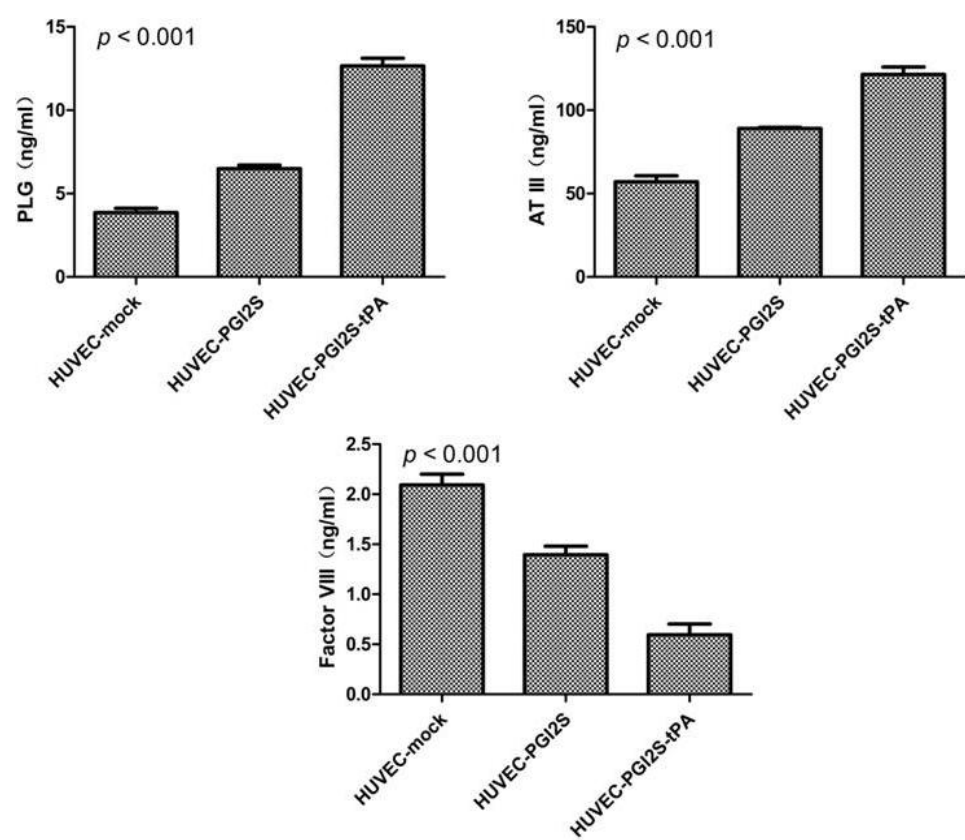
Figure 3. Expression of anticoagulation factors by HUVEC-mock, HUVEC- PGI2S , and HUVEC- PGI2S-tPA cells, ELISA were performed to measure the levels of ATIII , PLG and Factor VIII in cell homogenates, p values were calculated using one-way